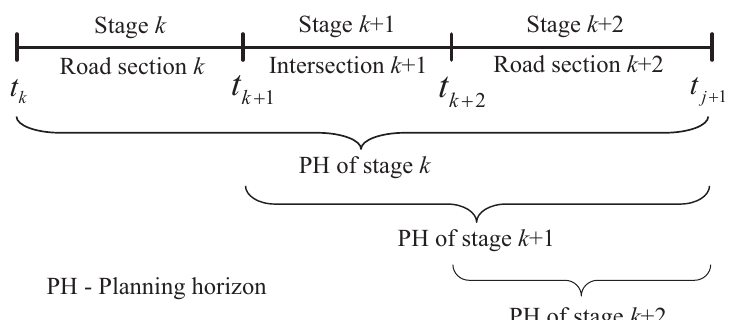
Figure 2 Illustration of the multiple-stage decision process